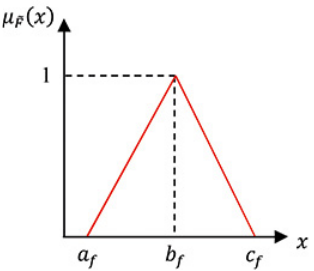
Figure 1. A Triangular Fuzzy